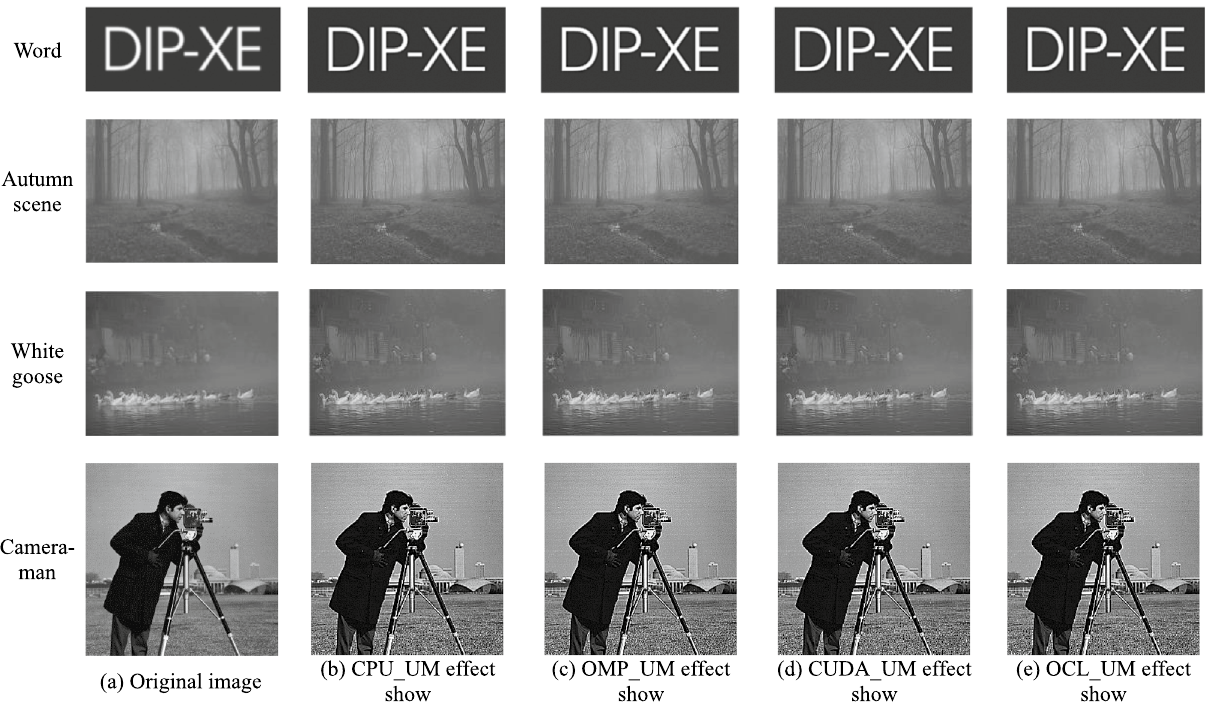
Figure 6. Unsharp masking image enhancement effect